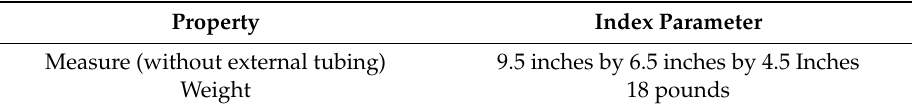
Table 5. Size of the energy recovery device.